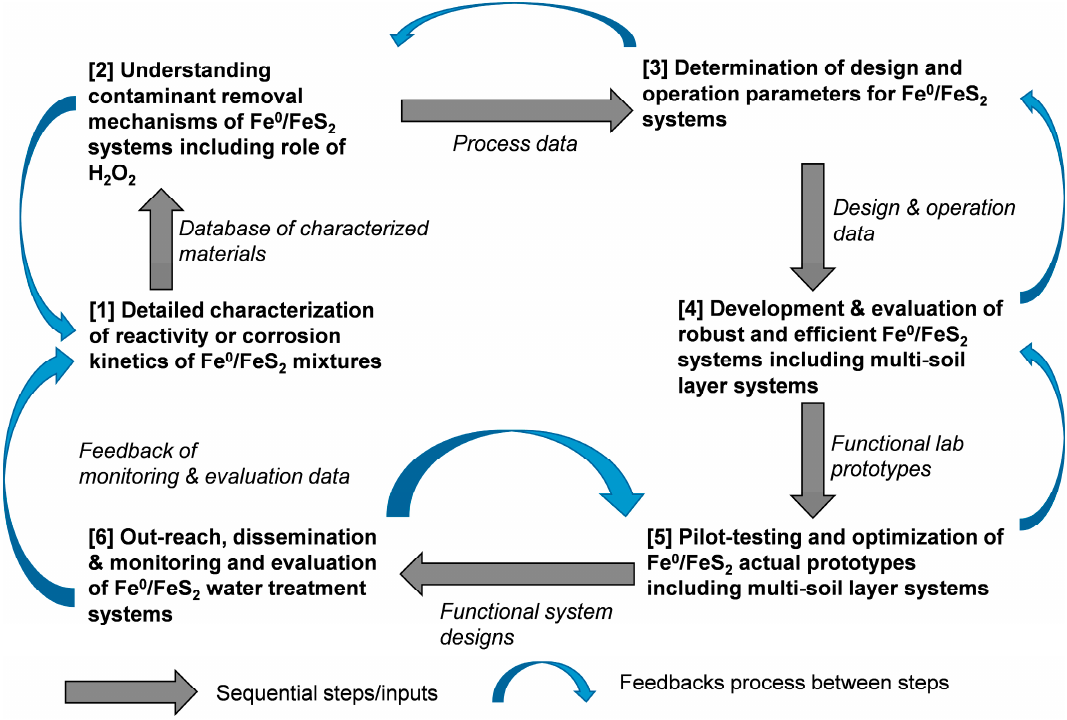
Figure 2. A conceptual depiction of proposed roadmap in the development of Fe 0 /FeS 2 /H 2 O water treatment systems, highlighting key thematic areas for future research.